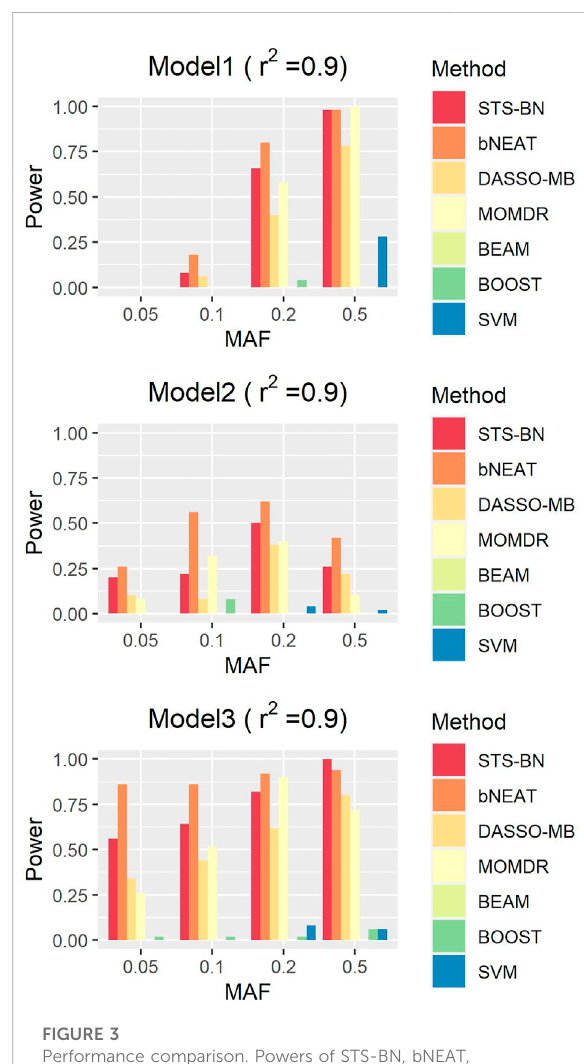
FIGURE 3 Performance comparison. Powers of STS-BN,